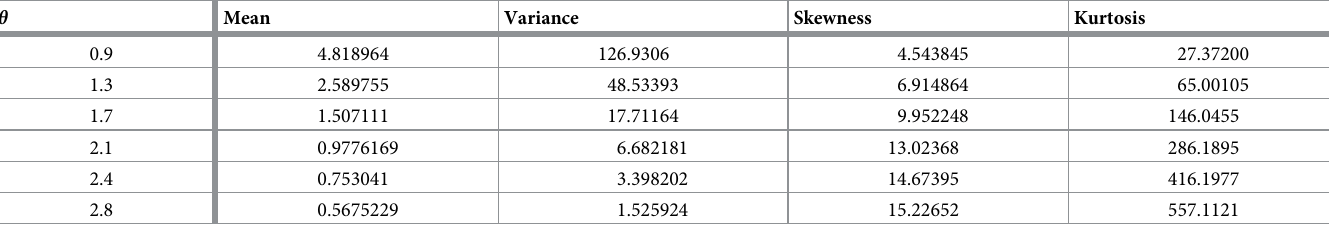
Table 1. Descriptive measures of TI-HTW distribution for α = 0.9, γ = 1 and different values of θ . θ Mean